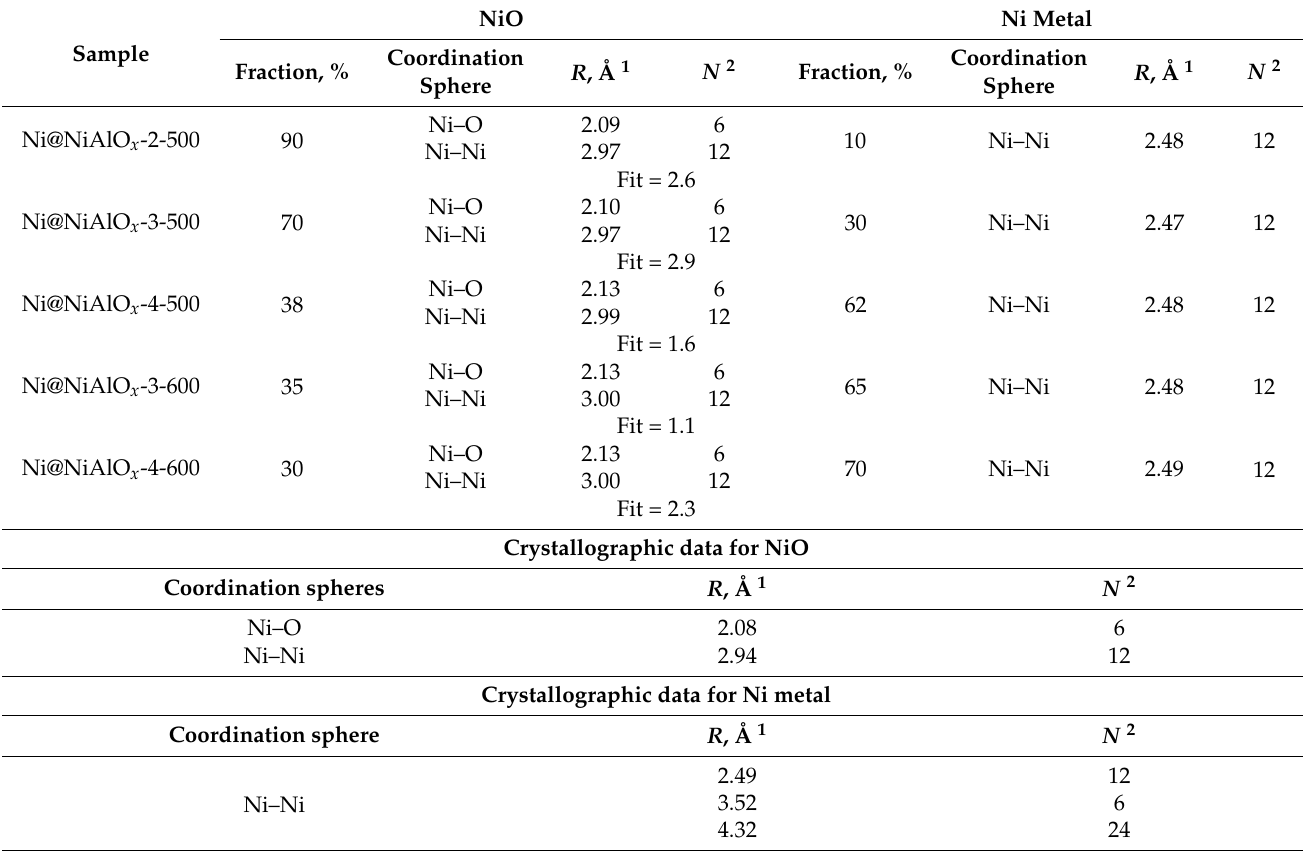
Table 3. Modeling of the Ni K EXAFS spectra with separation into two phases for the samples differing in the Ni/Al atomic ratio and reduction temperature. The accuracy upon decomposition into phases was ≈ 10%. Fit index shows the goodness of